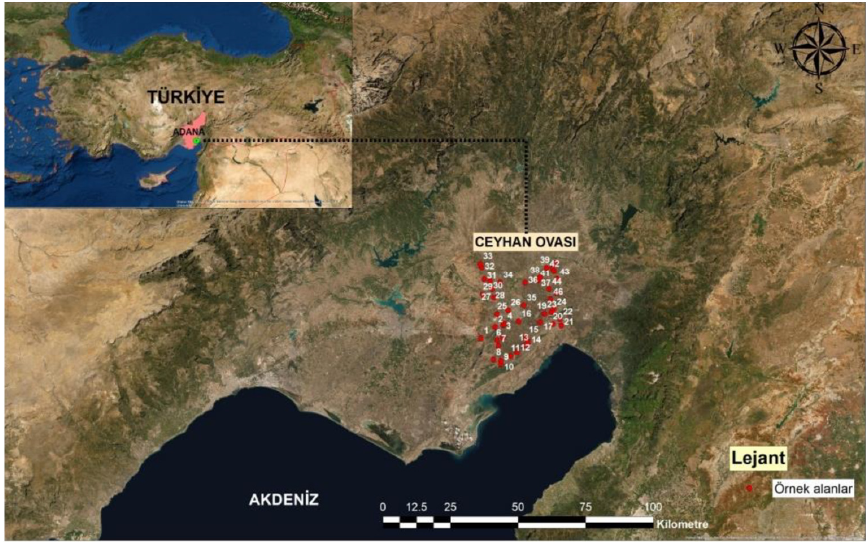
Figure 1. Location of the studied region in the Adana Province, Turkey [52].